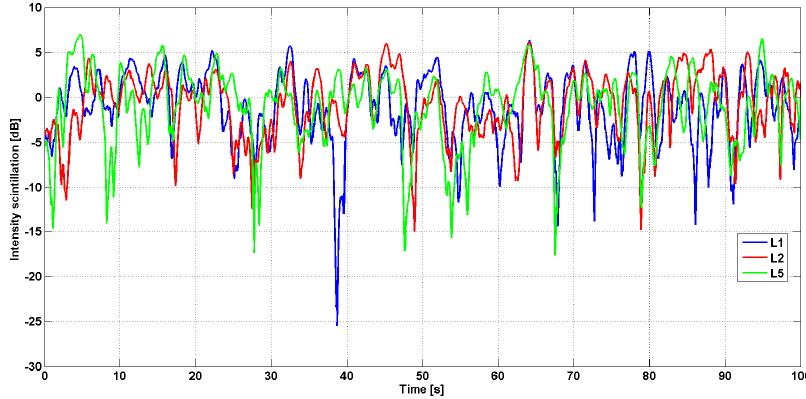
Figure 4. Simulated One-way ionosphere amplitude scintillations for S 4 = 0.8 and σ φ = 0.1 rad, at L1/E1 (blue), L2/E2 (red), and L5/E5 (red).